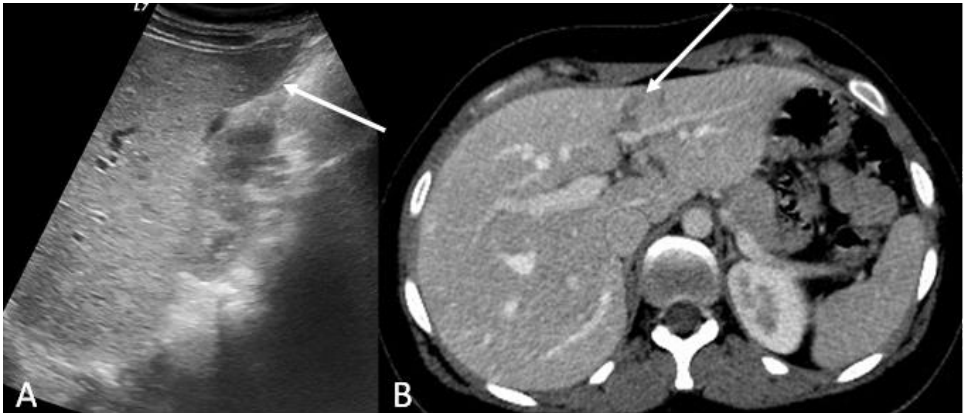
Figure 1. US ( A ) and enhanced-CT ( B , venous phase) of a 32 year old male who sustained major trauma. US scans of the liver shows a subtle hypoechoic area ( A , arrow). Enhanced-CT allows exhaustive evaluation of the suspected liver injury, depicting the whole extension of the liver laceration ( B , arrow) and excluding the presence of vascular injuries, thus allowing safe conservative management of the patient.